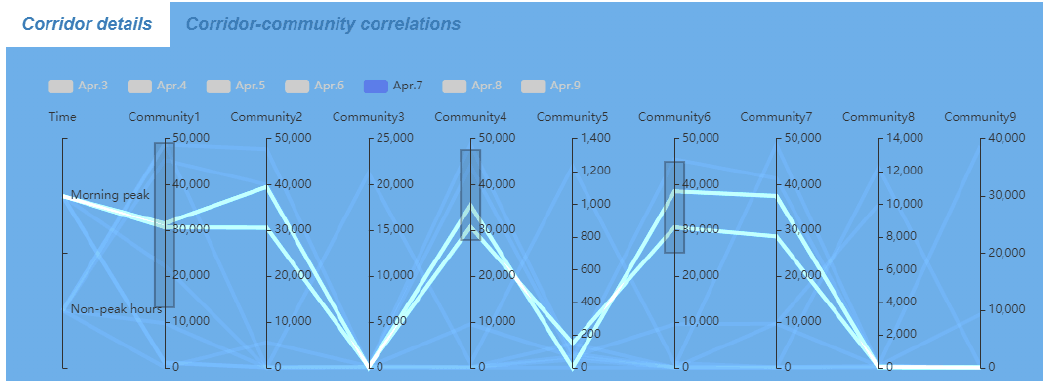
Figure 9. Parallel coordinate plot to illustrate correlations between transit corridors and mobility communities. Corridors discovered for April 7 are shown in the figure. After setting three filtering boxes, four corridors can be discovered and highlighted in the plot.